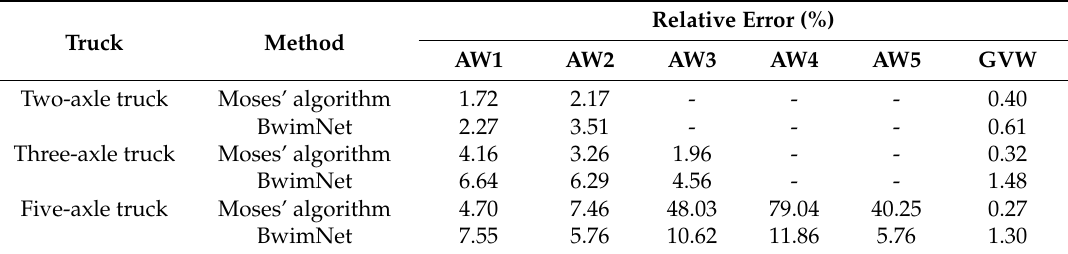
Table 3. Identification errors of axle weights estimation under good RSC.